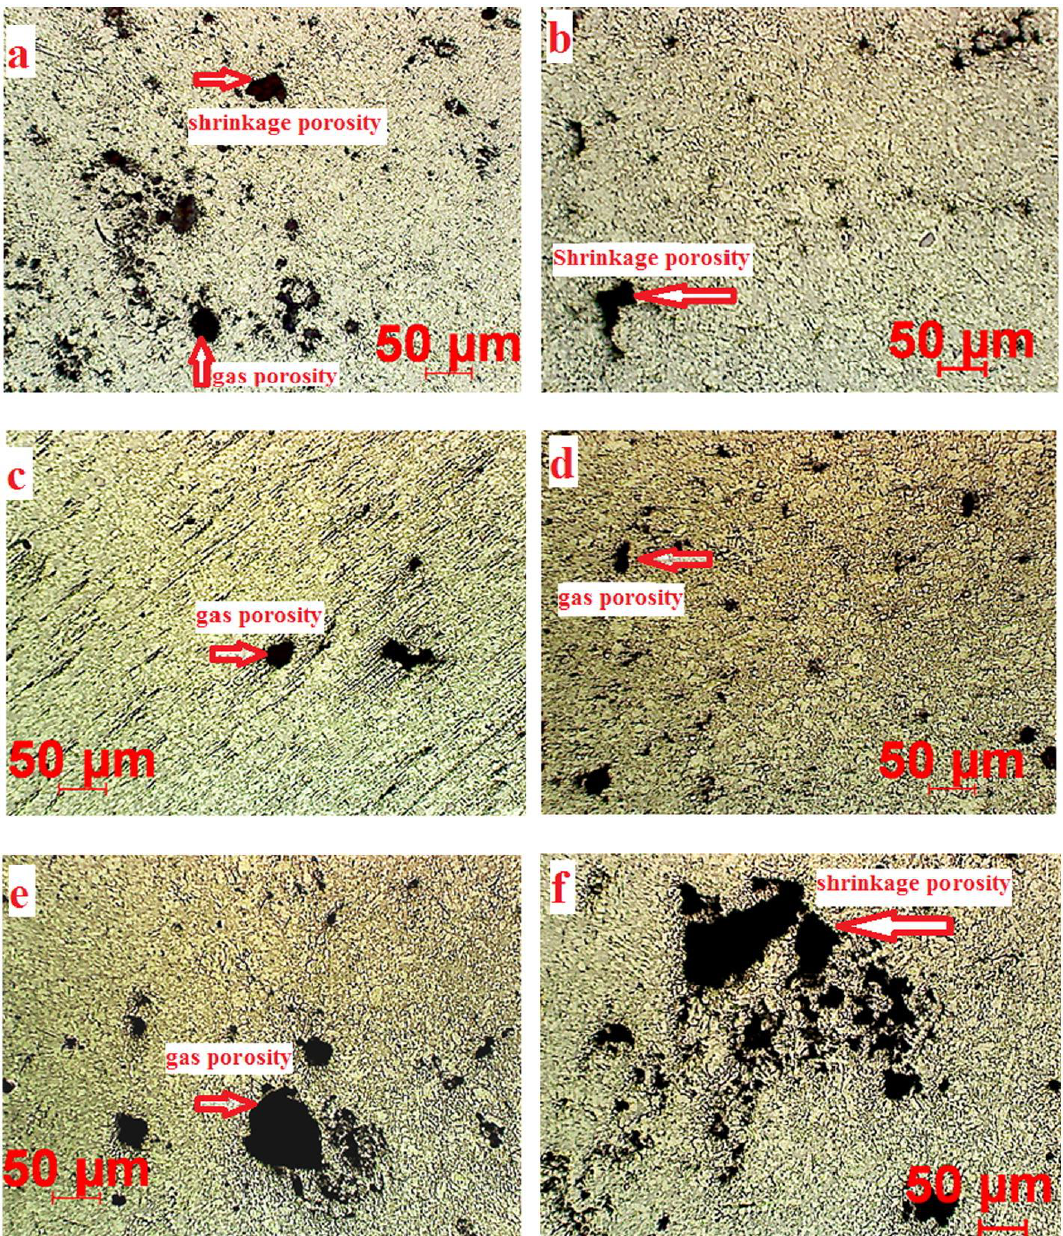
Figure 7. Micrographs of the AlSiCu alloy injected at different combinations of temperature and pressure ( a ) 579 ° C/35 MPa, ( b ) 579 ° C/70 MPa, ( c ) 643 ° C/35 MPa, ( d ) 643 ° C/70 MPa, ( e ) 709 ° C/35 MPa, and ( f ) 709 ° C/70 MPa, respectively. Reprinted with permission of [15].